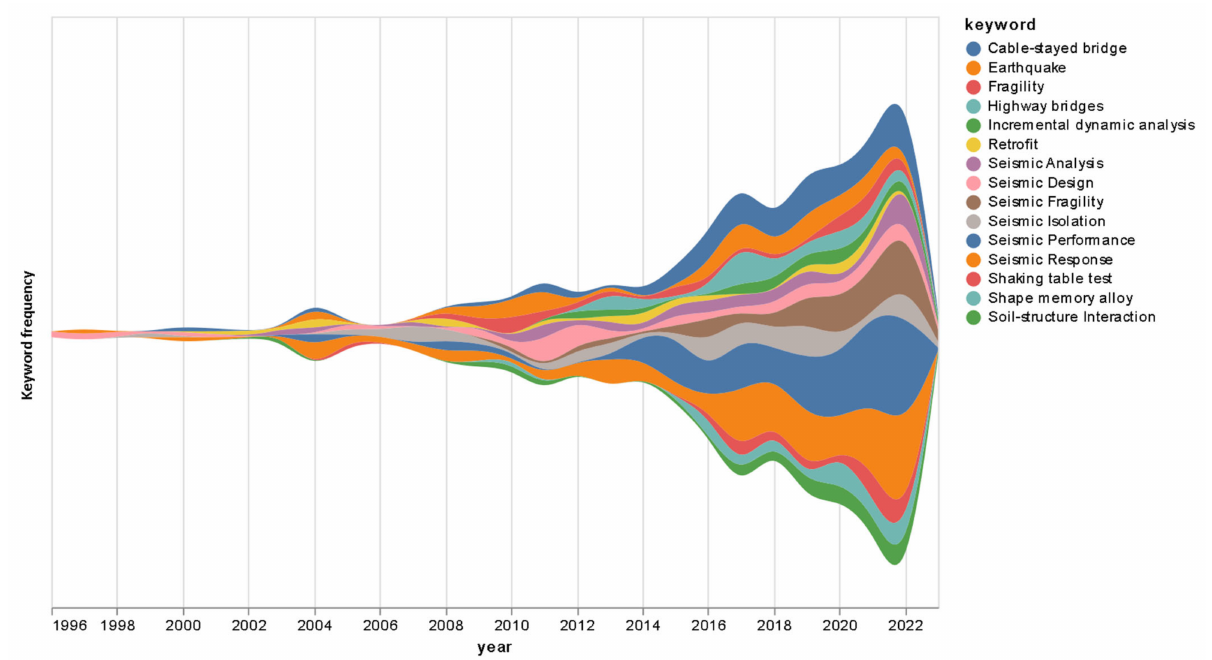
Figure 2. Top 15 most frequent keywords in academic papers considering bridges and seismic